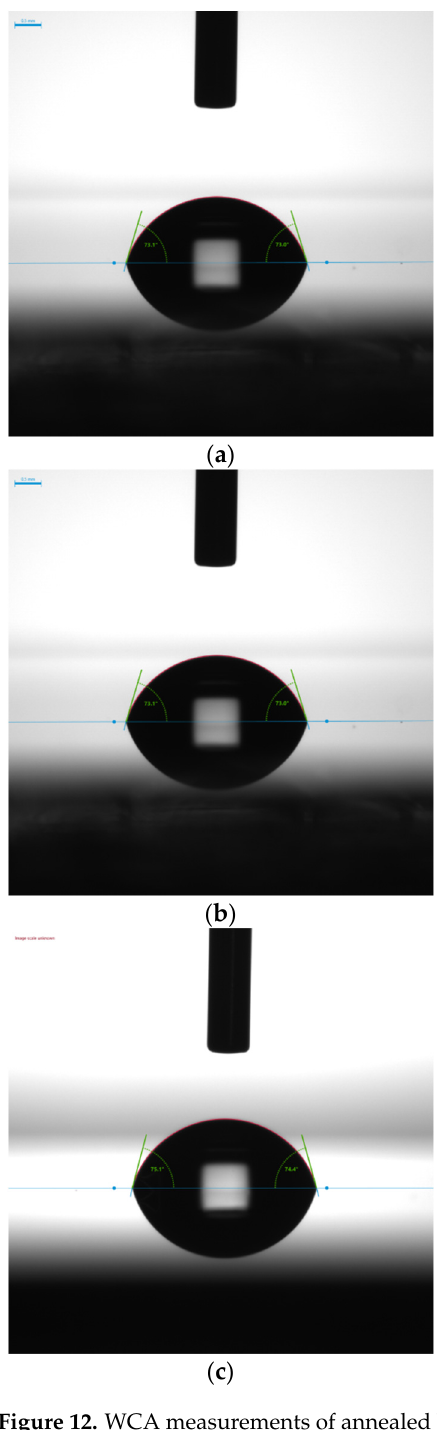
Figure 12. WCA measurements of annealed WN x samples, ( a ) WN300, ( b ) WN500 and ( c ) WN700.